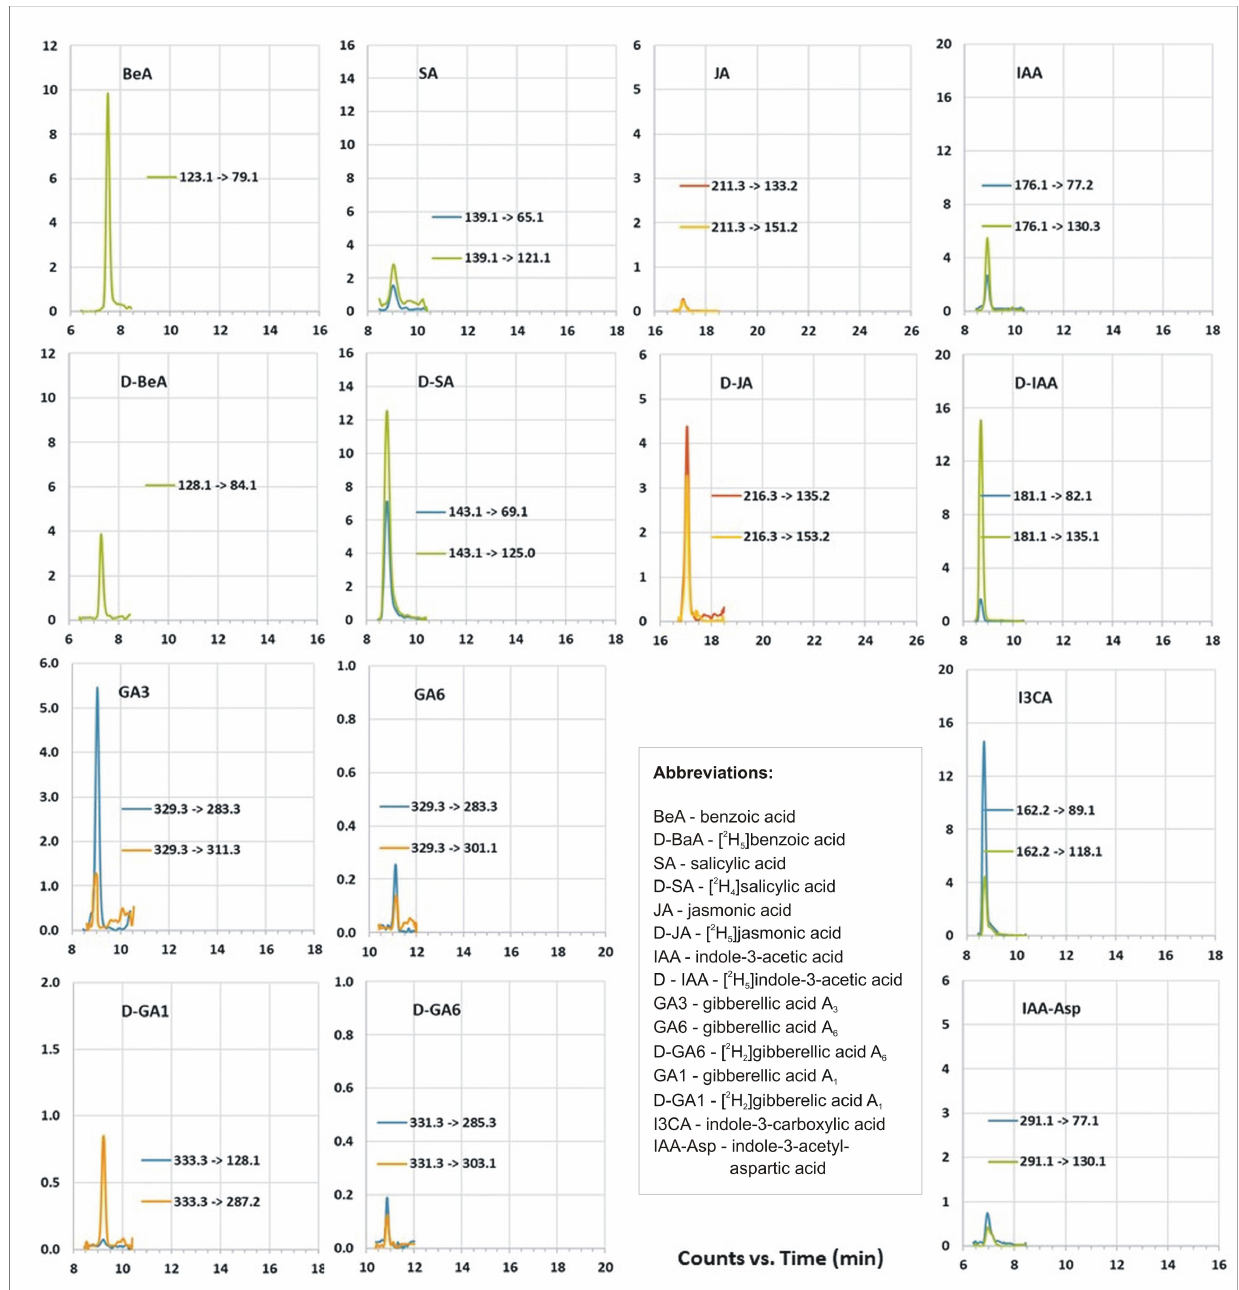
Figure 6. UHPLC-MS/MS growth regulator profile of bacterial extract, chromatograms of multiple reaction monitoring (MRM) transitions for the analyzed plant growth regulators and related substances.